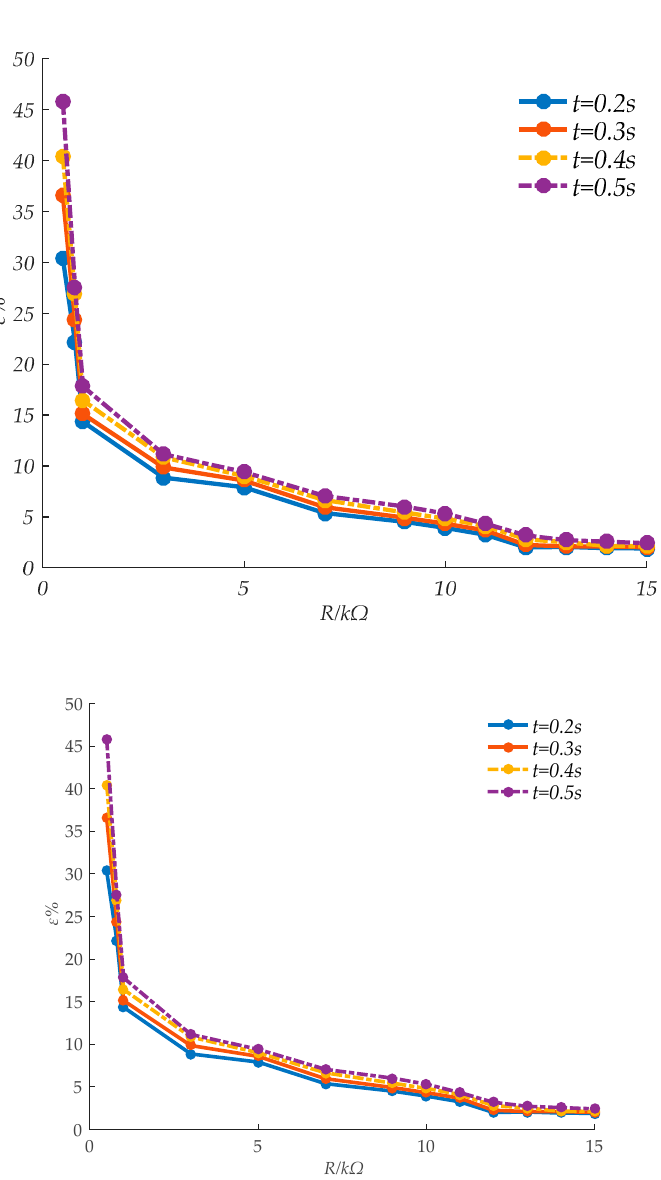
Figure 11. Relationship between resistor divider and the voltage error for different time interval.